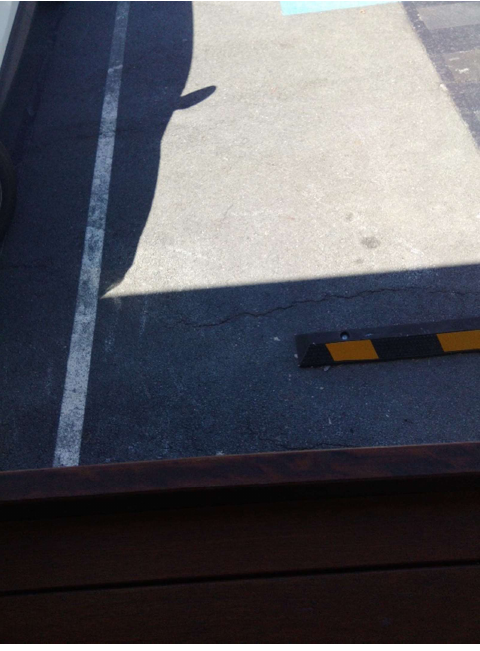
Figure 8. Carpark repainting.